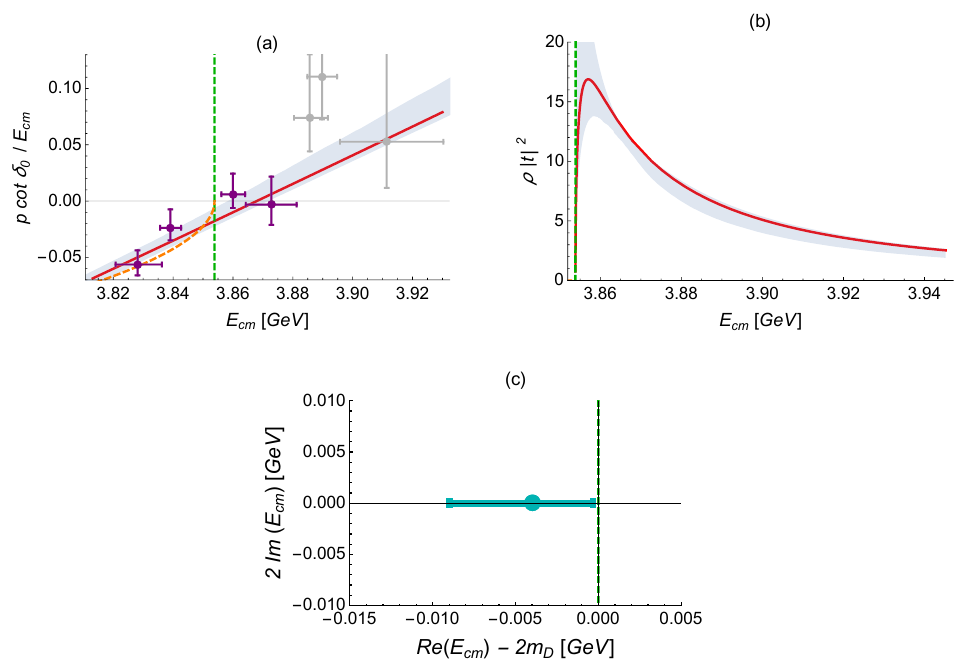
Figure 3 . D ¯ D scattering in partial wave l = 0 near threshold. The green dashed line denotes the D ¯ D threshold in the simulation where m D ’ 1927 MeV. (a) The violet crosses show the quantity p cot δ/E cm , related to the scattering phase shift δ , as a function of center-of-mass energy E cm . The red line indicates the parametrization of eqs. (8.1) and (8.2). The orange line represents ip/E cm . A bound state is located at the energy where the red and orange curves intersect. (b) The quantity ρ | t | 2 that is proportional to the number of D ¯ D events in experiment N ( ρ = 2 p/E cm ). The gray bands represent the uncertainty as defined in appendix A. (c) Position of the pole of the scattering matrix on sheet I: the real component corresponds to the binding energy, presented in eq.